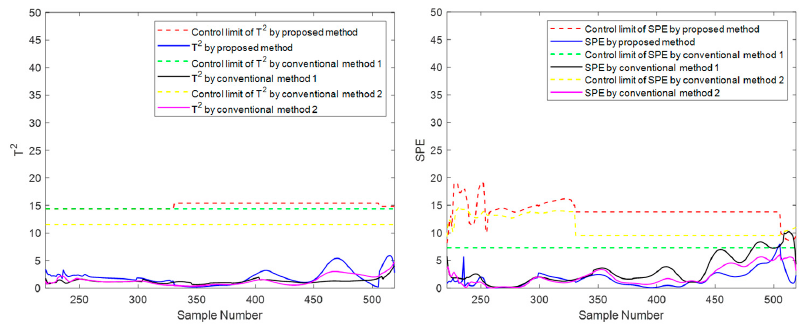
Figure 13. Online monitoring results of batch 41 by the proposed and conventional methods for the second phase.